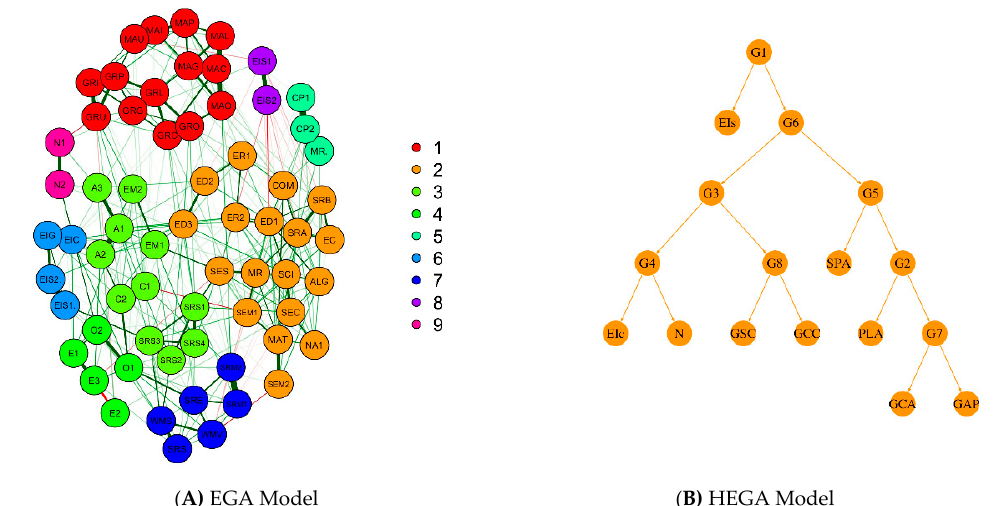
Figure 8. Network of abilities and processes as abstracted by exploratory graph analysis (Panel A ) and hierarchical organization of clusters as abstracted by hierarchical exploratory graph analysis (Panel B ). Note: clusters represent general academic performance measures (1: GAP), general cognitive ability (2: GCA), general self-representation of social competence cluster (3: GSC), plasticity of personality (4: PLA), spatial reasoning (5: SPA), knowing one’s own emotions (6: EIc), self- representation of mental efficiency (7: GCC), emotional stability (8: EIs), and neuroticism (9: N) from the Big Five, respectively.